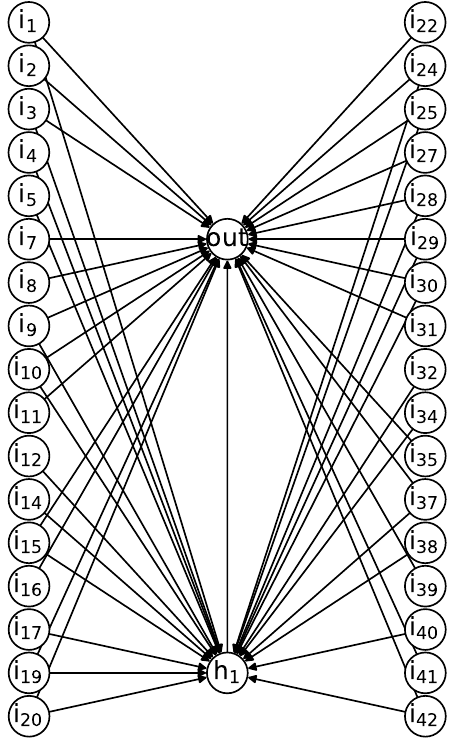
Figure 5. Best SN P system evolved for the RUL prediction task on CMAPSS